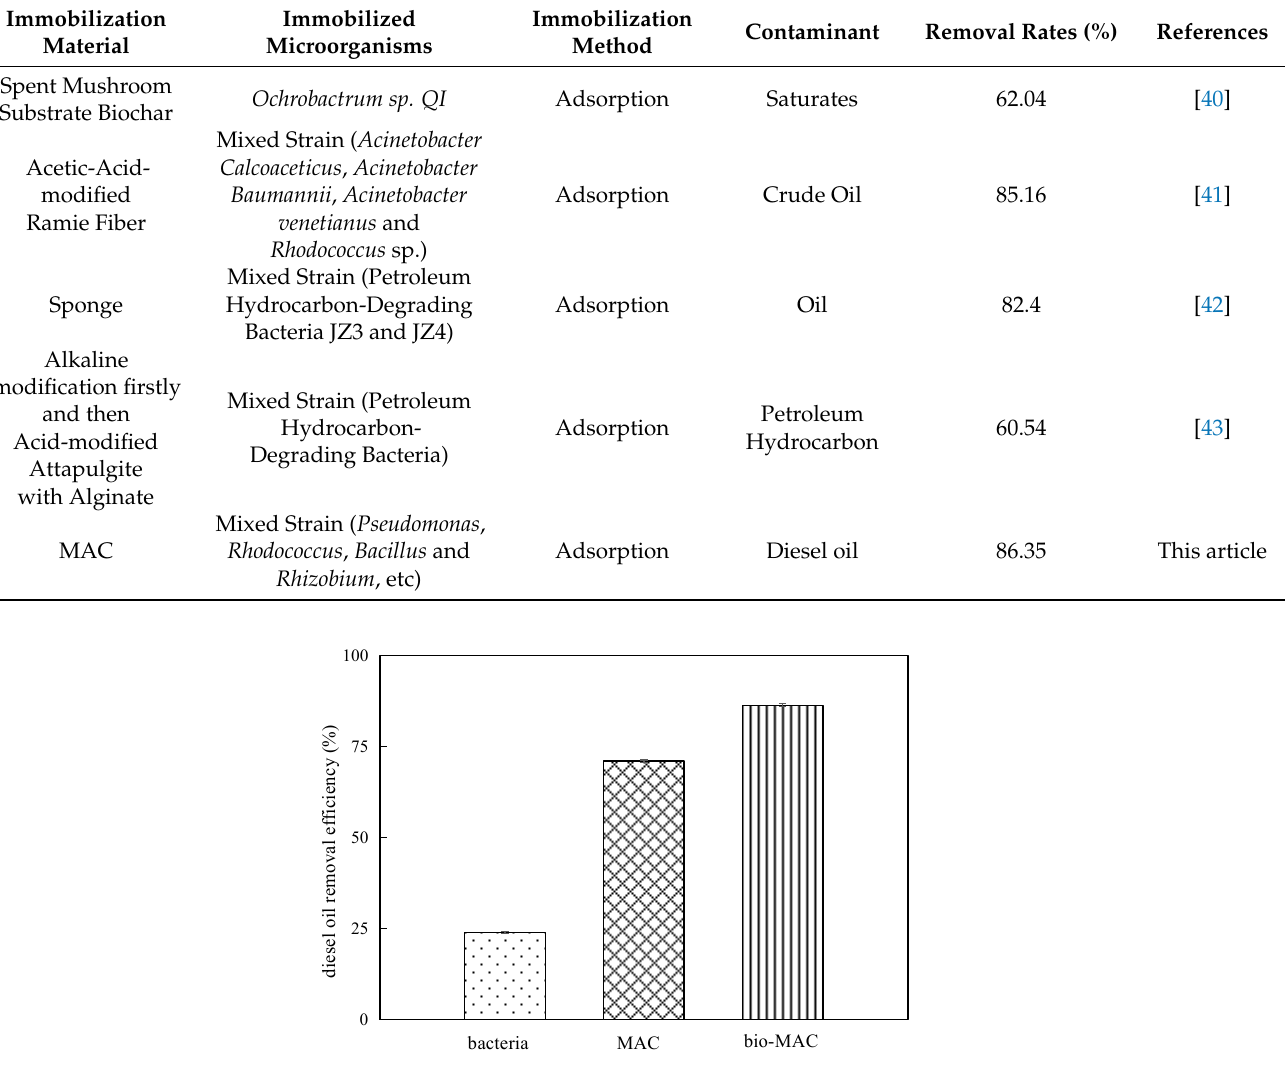
Figure 7. Comparison of the diesel oil removal efficiency rates of degrading bacteria, MAC and bio- MAC. Table 2. The summary of the main microorganism immobilization materials used for oil removal in water.